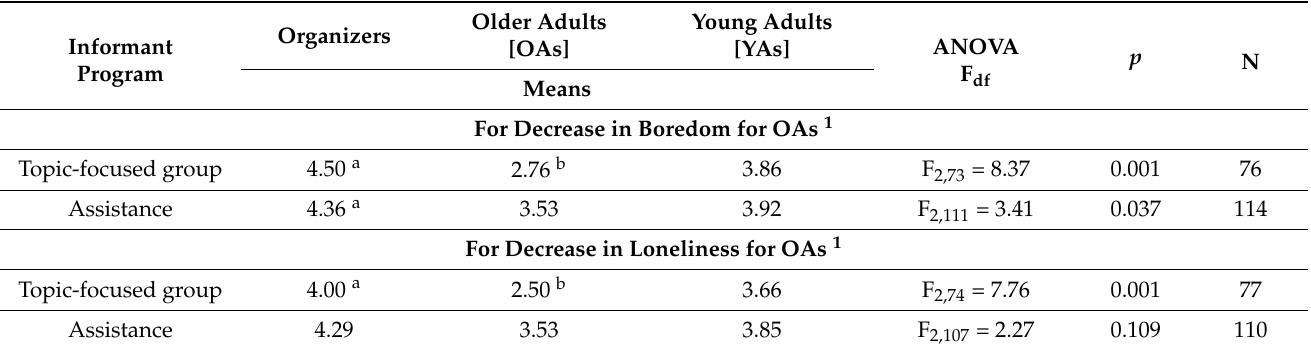
Table 3. Differences between informant reports of